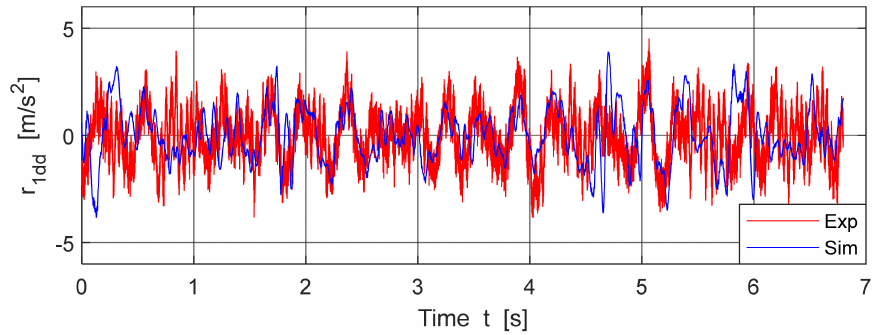
Figure 28. Acceleration in the CG of vehicle sprung mass, V = 52.85